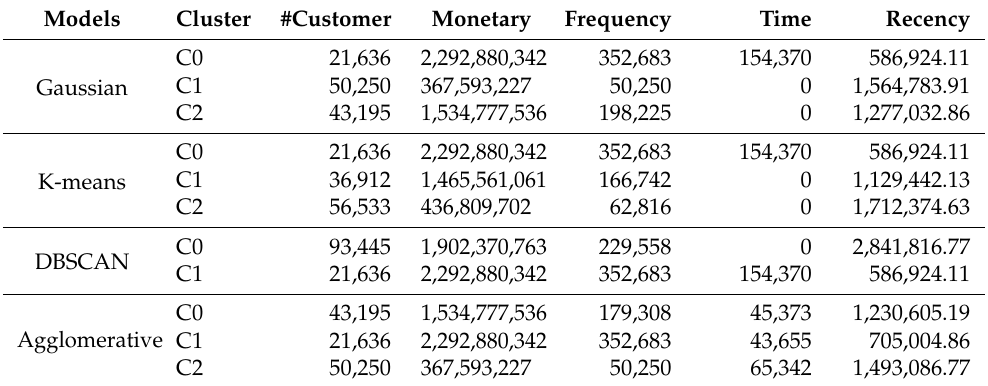
Table 7. Clusters distribution, number of customers, recency, frequency, monetary, and time for different clusters and algorithms.